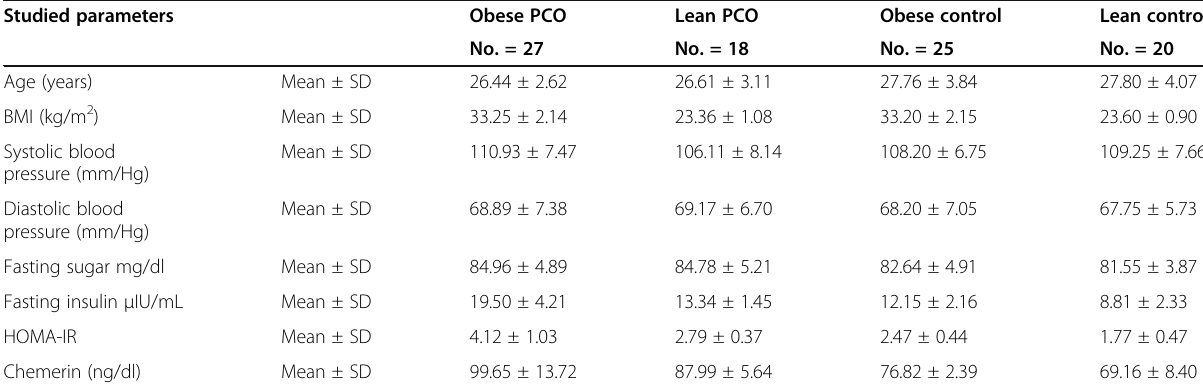
Table 1 Descriptive data of the studied groups as regards all studied parameters Studied parameters